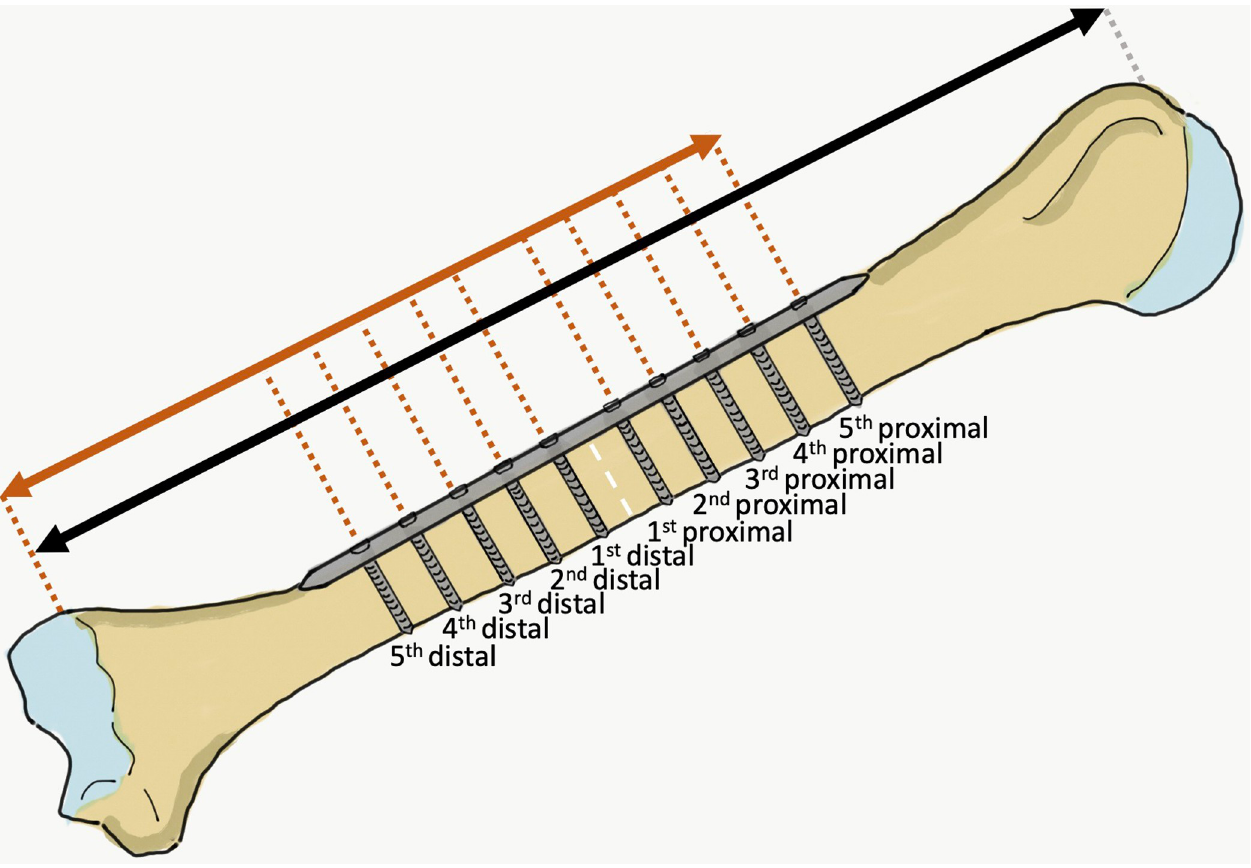
Fig 3. Anterior view of a right upper arm, with an imaginary fracture line at the midpoint between the tip of the greater tuberosity and the lateral epicondyle (white dotted line). The distances were measured from the lateral epicondyle to the tip of the greater tuberosity of the humerus (entire humeral length; black arrow) and the center of each screw hole (orange arrow). The relative distance ratio of each screw hole was calculated based on the distance from the lateral epicondyle to each screw hole (orange arrow) and the entire humeral length (black arrow).